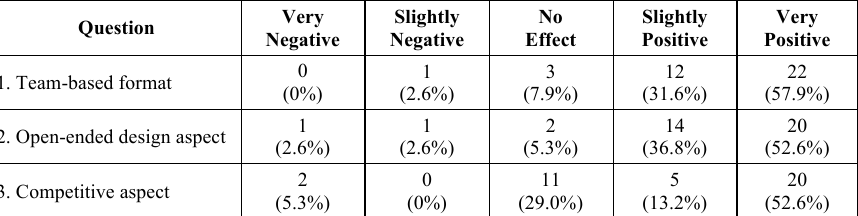
Table 4. Student learning experience survey results (post-OEDE laboratory